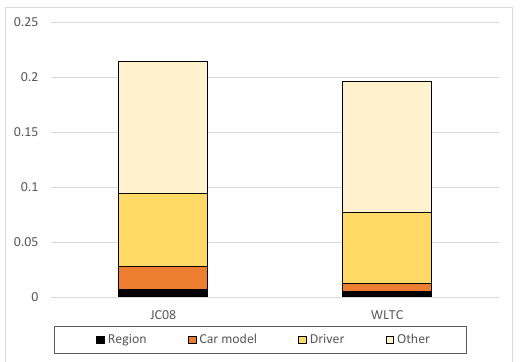
Figure 6. Deviation factors decomposition of standard error of the regression. Note: Y -axis shows the standard error of the residuals.